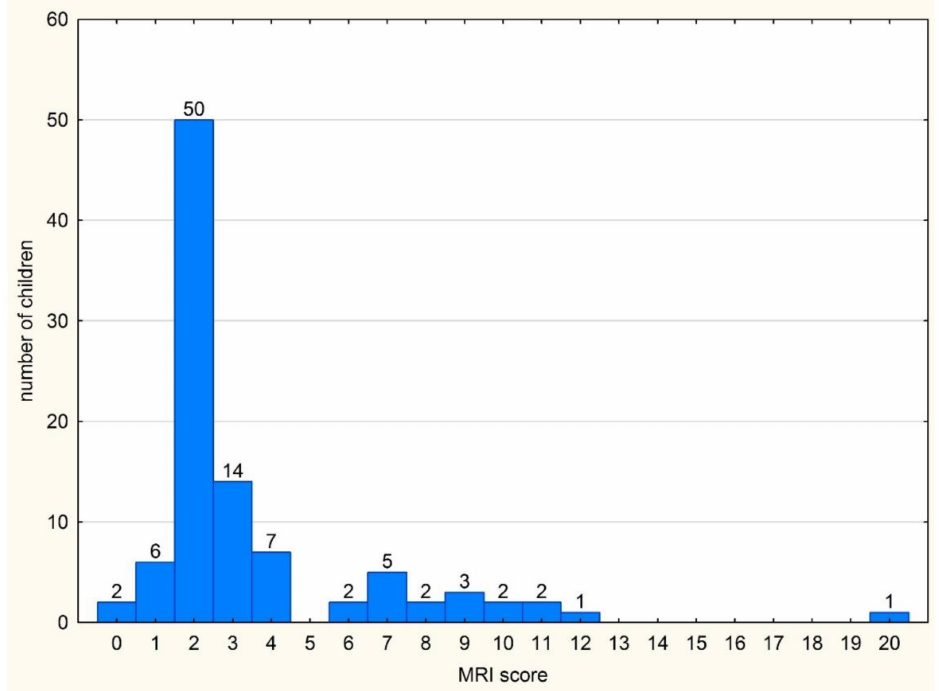
Figure 3. The frequency of individual MRI scores in the whole group of patients ( n = 97).